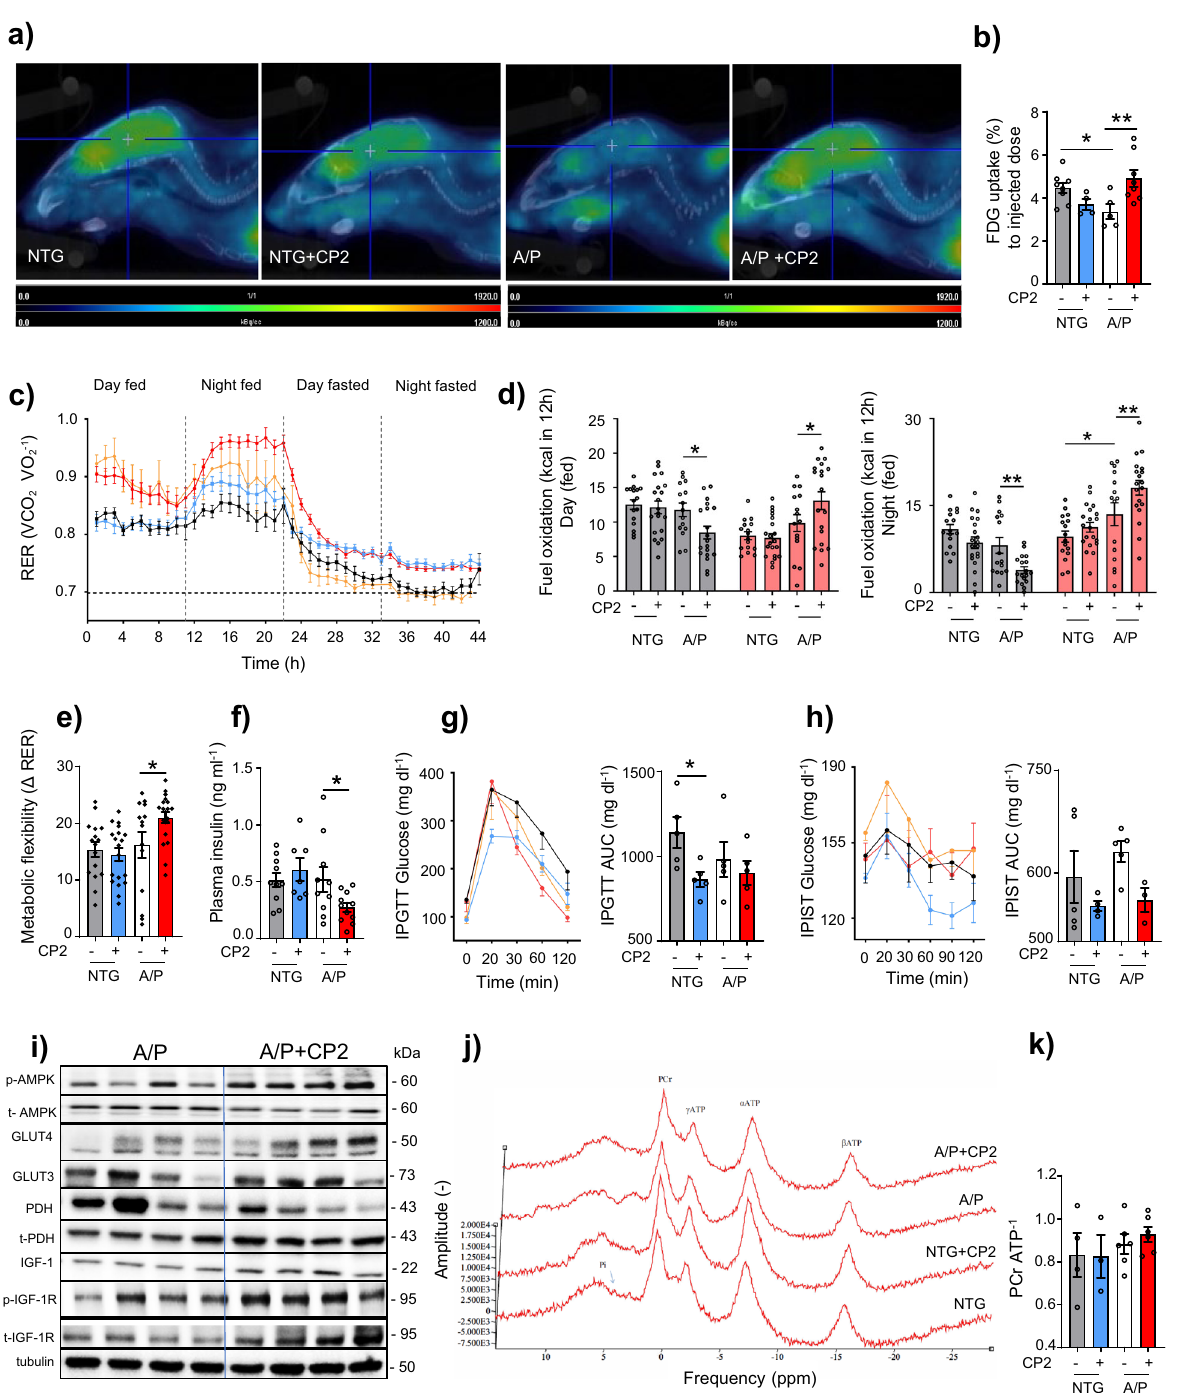
Oxidative stress and in fl ammation induce cell proliferation arrest and the cell senescence phenotype, contributing to age- related diseases. Therefore, we examined levels of senescent cells in inguinal (ING) and periovarian (POV) adipose tissue from NTG and APP/PS1 mice using β -Galactosidase ( β -Gal) staining 34 (Supplementary Fig. 9b – d). CP2 treatment signi fi cantly reduced abundance of senescent cells in both APP/PS1 and NTG mice. In AD patients, increased levels of ceramides, especially Cer16, Cer18, Cer20, and Cer24, were directly linked to oxidative stress and A β pathology 35 . Targeted metabolomic pro fi ling conducted in plasma of CP2-treated mice revealed a signi fi cant decrease in